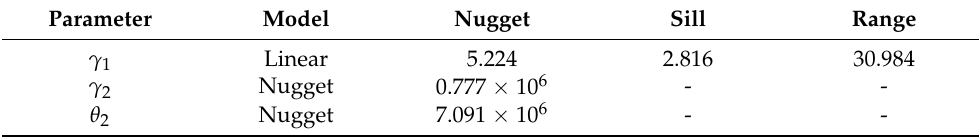
Figure 13. The graph shows points on the empirical semivariogram for the north wing. The line was fitted by the least square method (LSM) of the theoretical model for the parameters: ( a ) γ 1 , ( b ) γ 2 , ( c ) θ 2 . Table 4. Parameters of theoretical semivariogram models for the north wing. Table 3. Parameters of theoretical semivariogram models for the south wing.